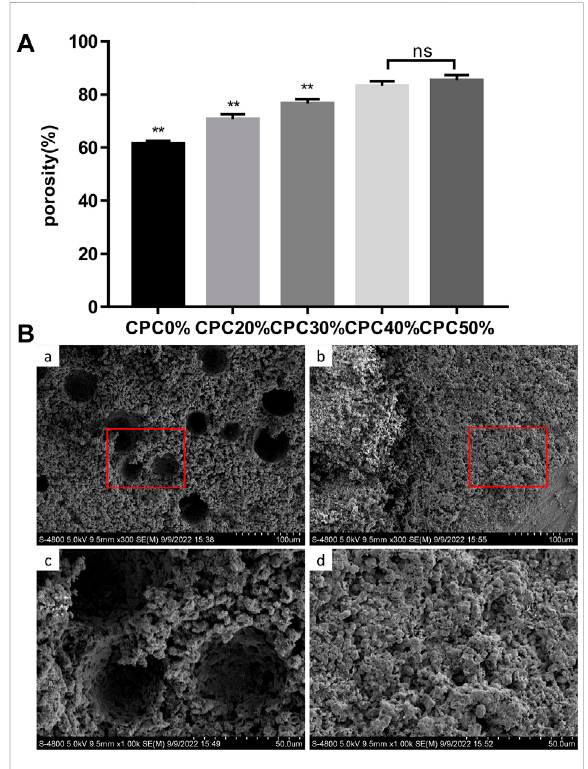
FIGURE 3 (A) Porosity of composite scaffolds with different microcapsule volume ratios measured with the Archimedes drainage method. (B) Pore distribution of composite scaffolds observed via electronmicroscopy: (A) and (C) CPC+ACA, (B) and (D) CPC. (*: p < 0.05, **: p < 0.01, ns: p > 0.05).